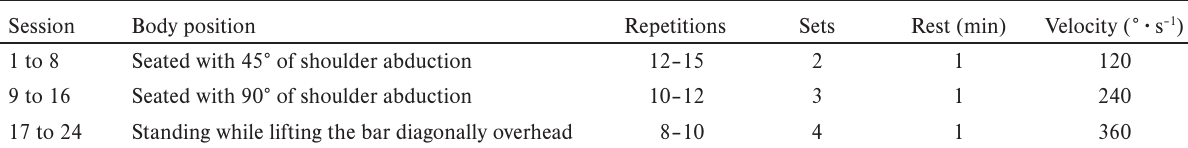
Details of additional isokinetic and isotonic training